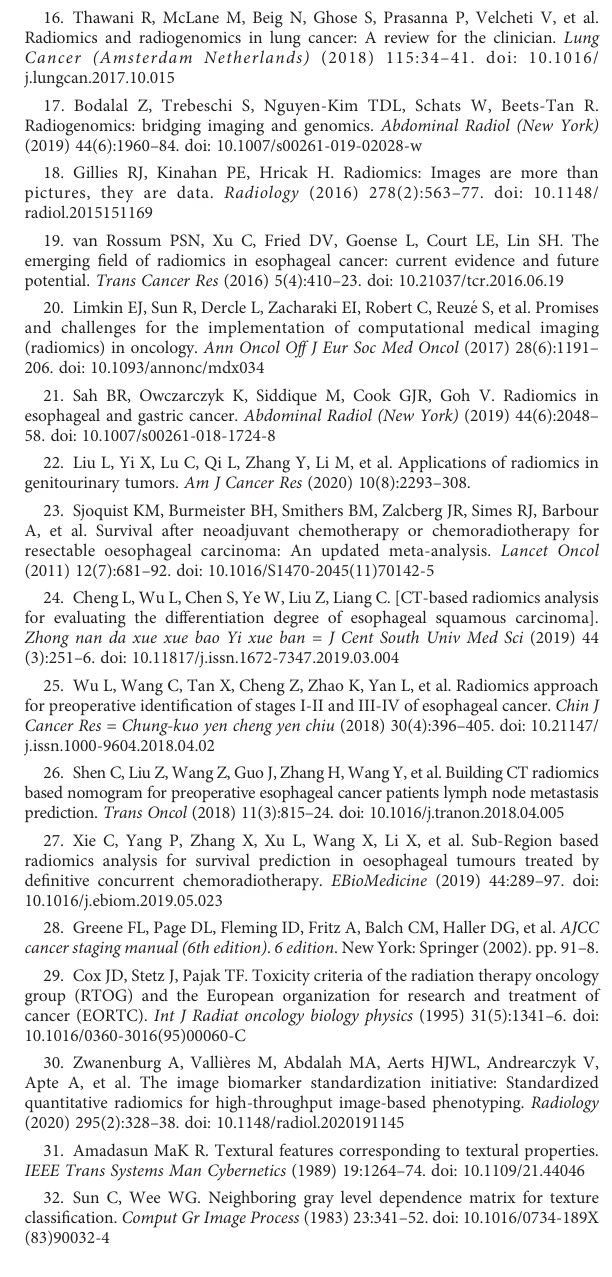
SUPPLEMENTARY FIGURE 1 The change in the mean esophageal stenotic ratio of 65 patients before treatment to 1yearafter treatment. Sevenpoints in x axisrepresentbefore treatment, twentieth fraction, complete treatment, 3, 6, 9, and 12 months after completing treatment.